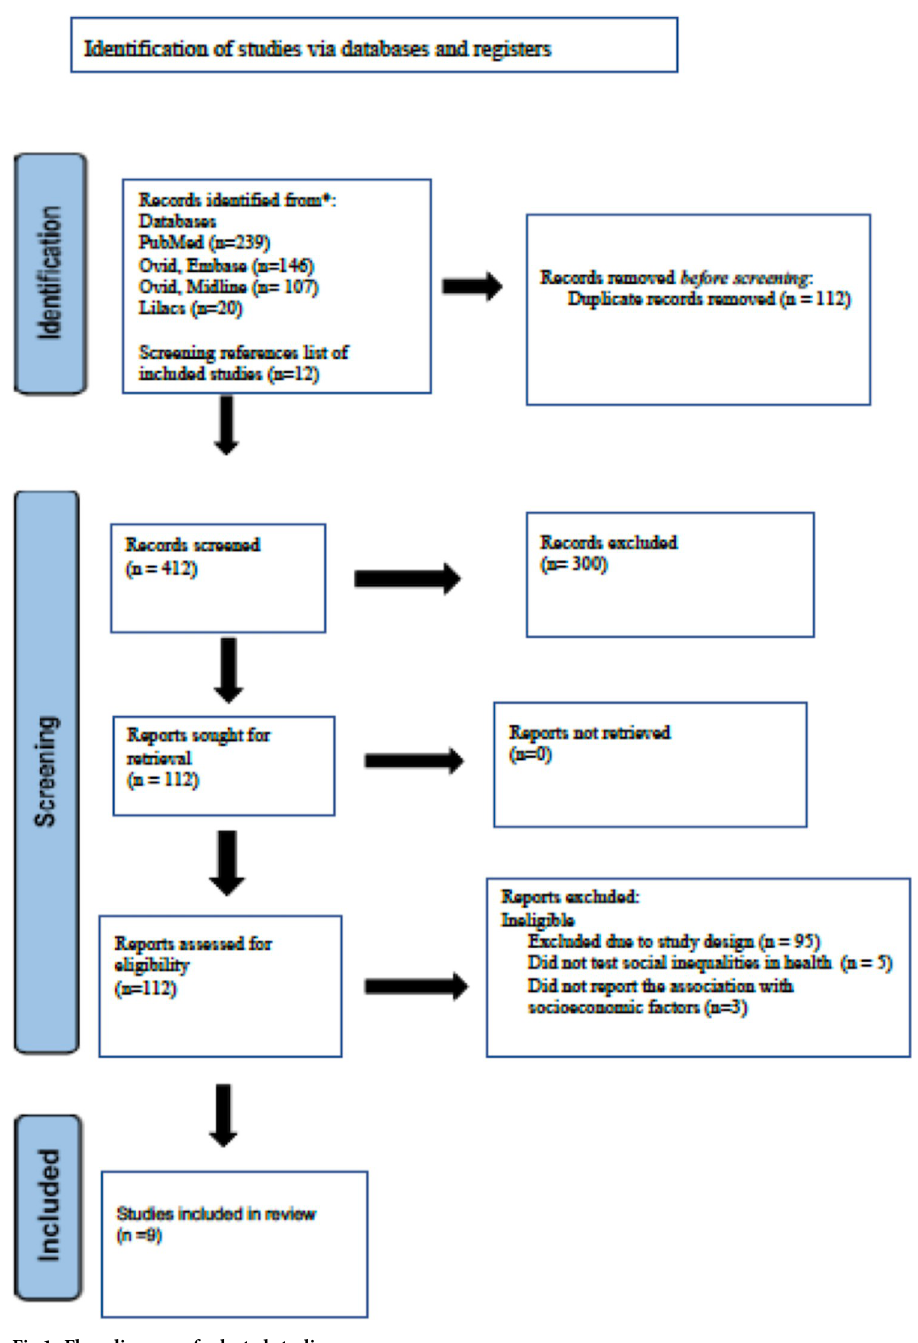
Fig 1. Flow diagram of selected